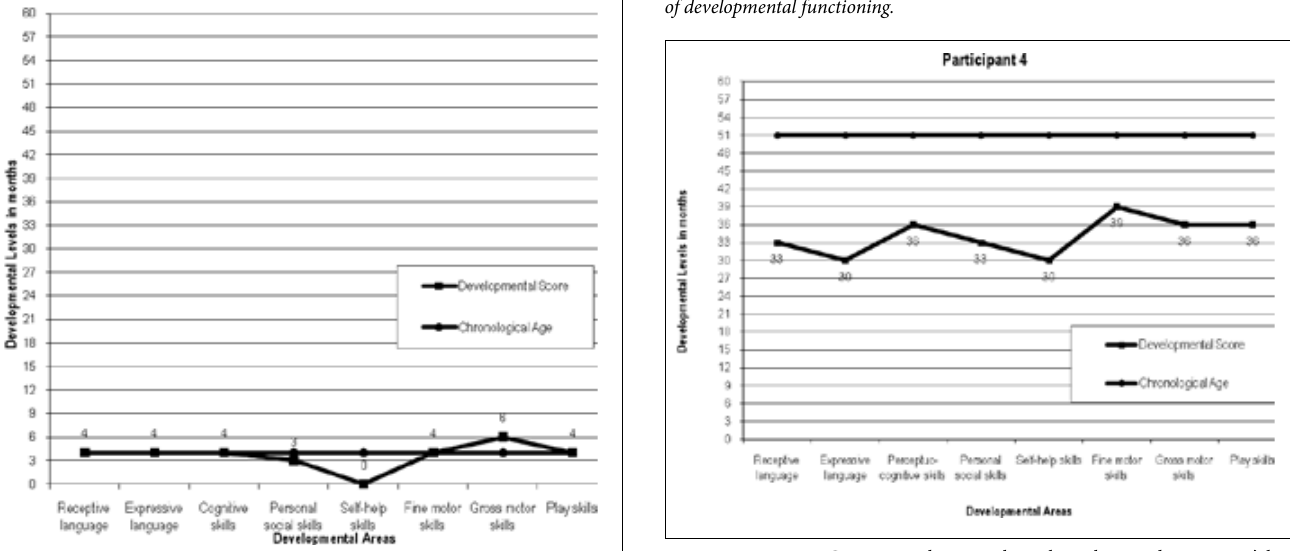
Fig. 4. Participant 4: Comparison between chronological age and participant’s level of developmental functioning.